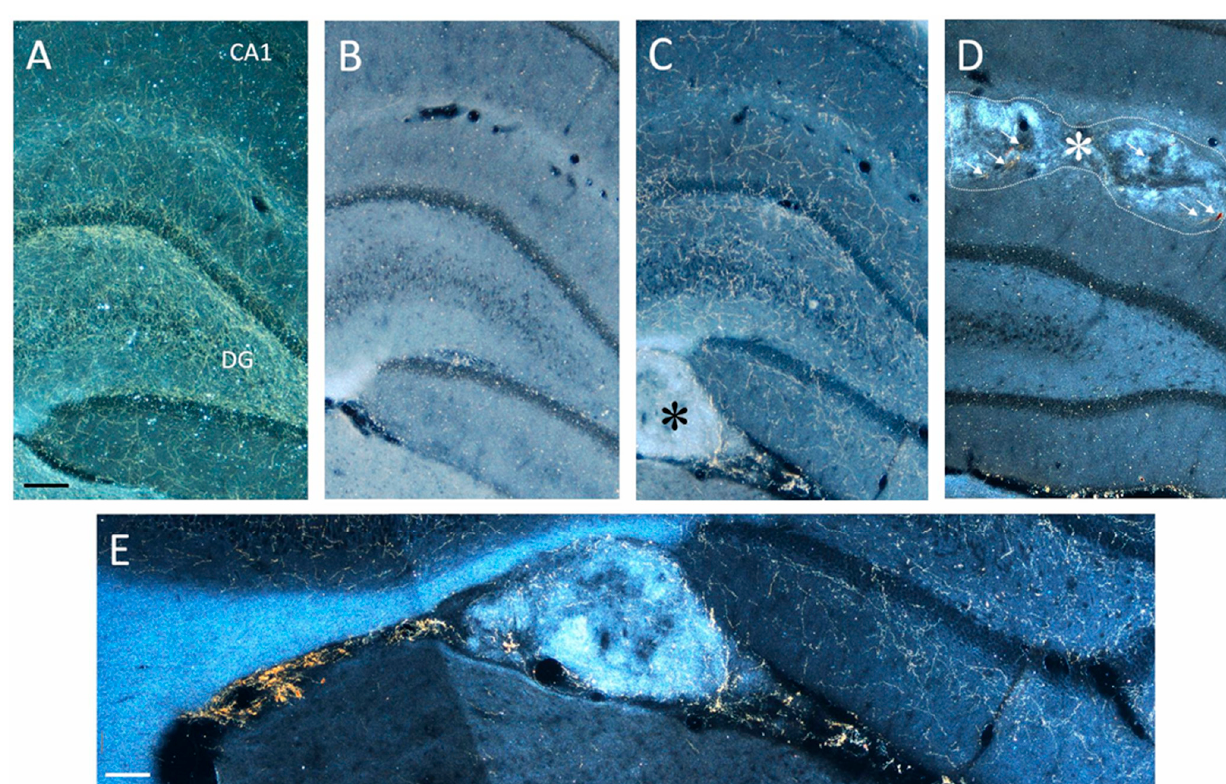
Figure 5. Darkfield photomicrographs illustrating the distribution of DBH-immunoreactive fibers in the hippocampus of Control ( A ), Lesioned ( B ) LC-transplanted ( C ) and CBL-transplanted animals ( D ) about 36 weeks after lesioning and grafting. Note the near complete loss of DBH-positive fibers in the hippocampus of Lesioned animals ( B ) and CBL-transplanted animals ( D ) compared to control ( A ) and the close to normal pattern of noradrenergic innervation reinstated by the transplanted LC tissue ( C ). In ( E ), the morphology of the transplanted LC tissue and the outgrowing DBH-immunoreactive fibers is illustrated at higher magnification. Note the remarkable anatomical integration of the LC graft within the host tissue environment and the smooth fiber growth at the graft-host border. CA, cornu